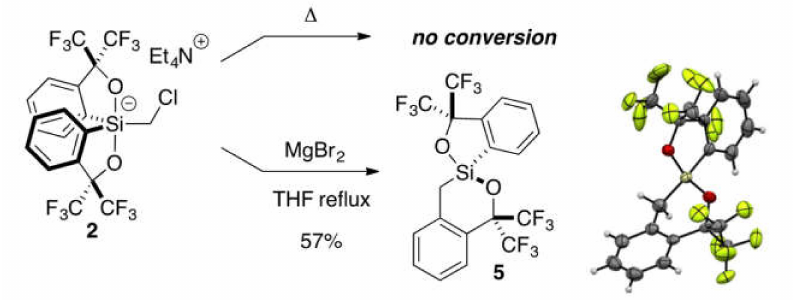
Figure 3. Synthesis of rearranged product 5 and the corresponding X-ray structure (CCDC-2129139) Ellipsoids are shown with 50% of